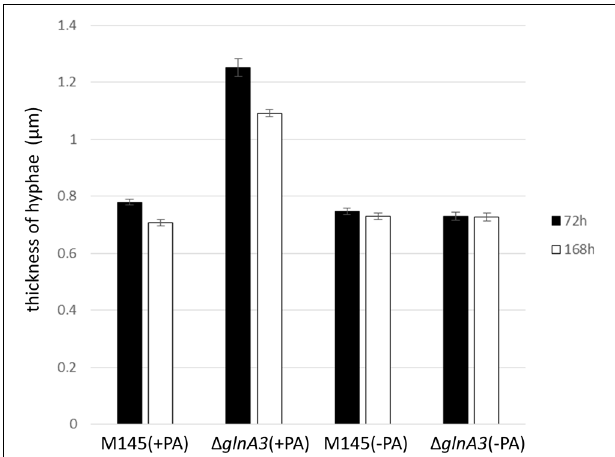
FIGURE 10 | Comparison of the hyphae thickness of parental strain S. coelicolor M145 and (cid:49) glnA3 mutant grown in the presence of polyamines. Parental strain S. coelicolor M145 and (cid:49) glnA3 mutant were cultivated in YEME:TSB (1:1) medium with or without polyamines. The hyphae thickness was measured after 72 and 168 h of growth. Error bars indicate standard error of n = 100 biological